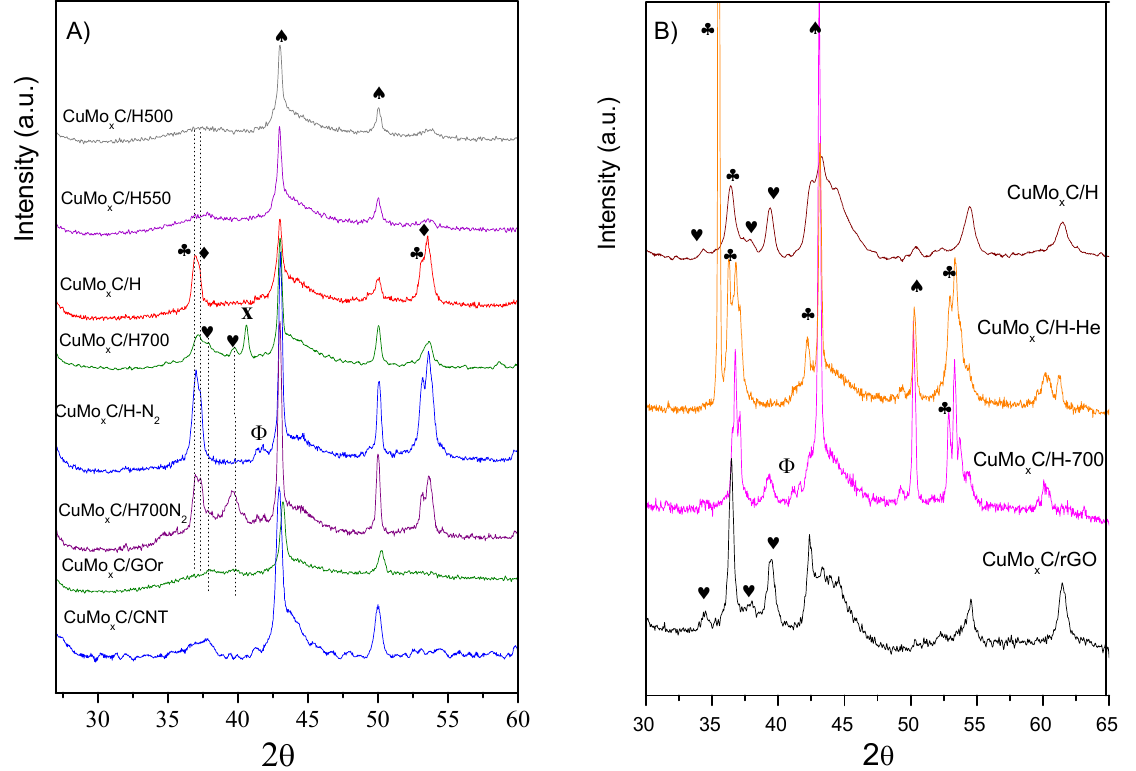
Figure 1. ( A ) In situ XRD patterns under H 2 or inert atmosphere (N 2 ) of the catalysts up to 600 ◦ C or 700 ◦ C. ( B ) XRD patterns of spent catalysts. Symbols: Mo x C MoO x C y , MoO 2 , x Mo, Cu, Φ CuO.